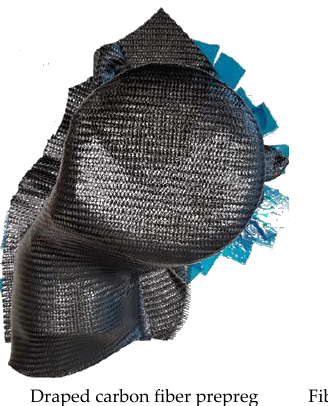
Figure 13. Results from the manual draping and evaluation of fiber orientation for the 0° ply (top shell).